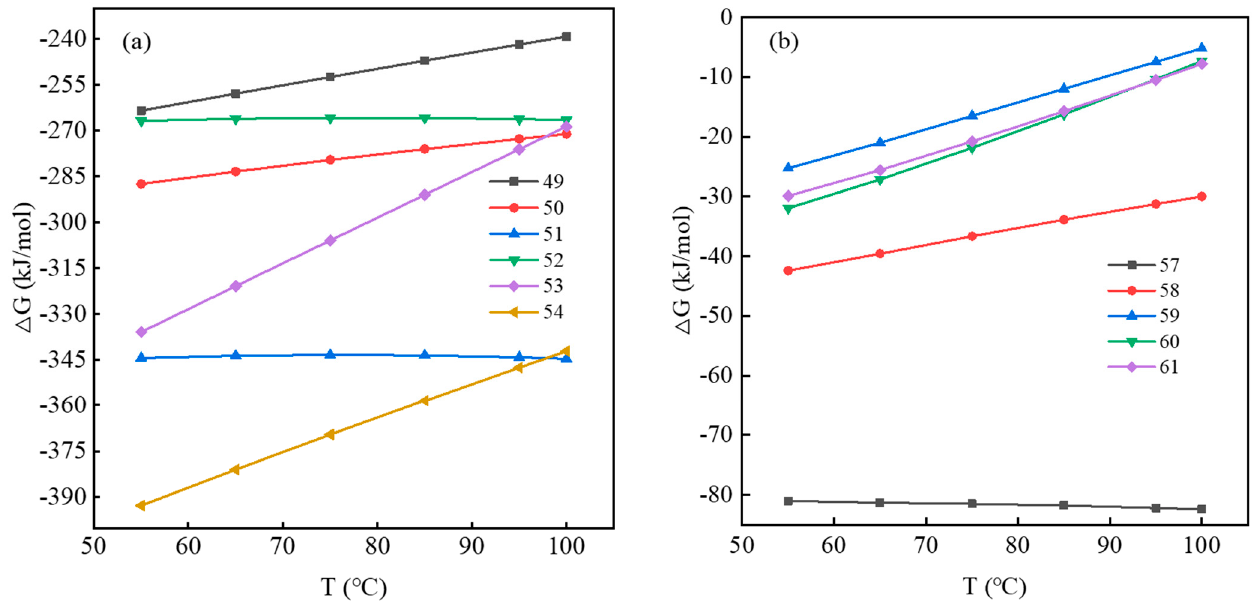
Figure 5. ∆ G change curve with T: ( a ) Equations (53)–(58); ( b ) Equations (61)–(65).